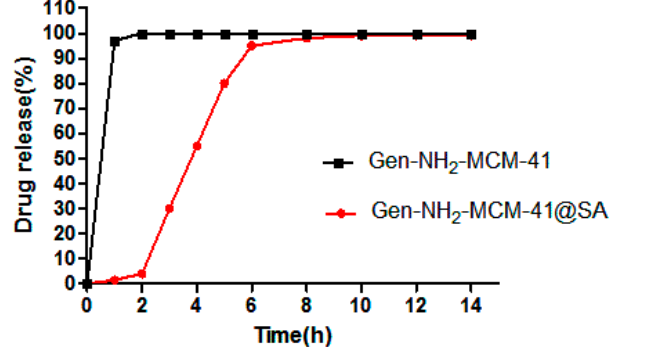
Figure 12. Gen-NH 2 -MCM-41 and Gen-NH 2 -MCM-41@SA in vitro drug release curve of nanoparti- cles.